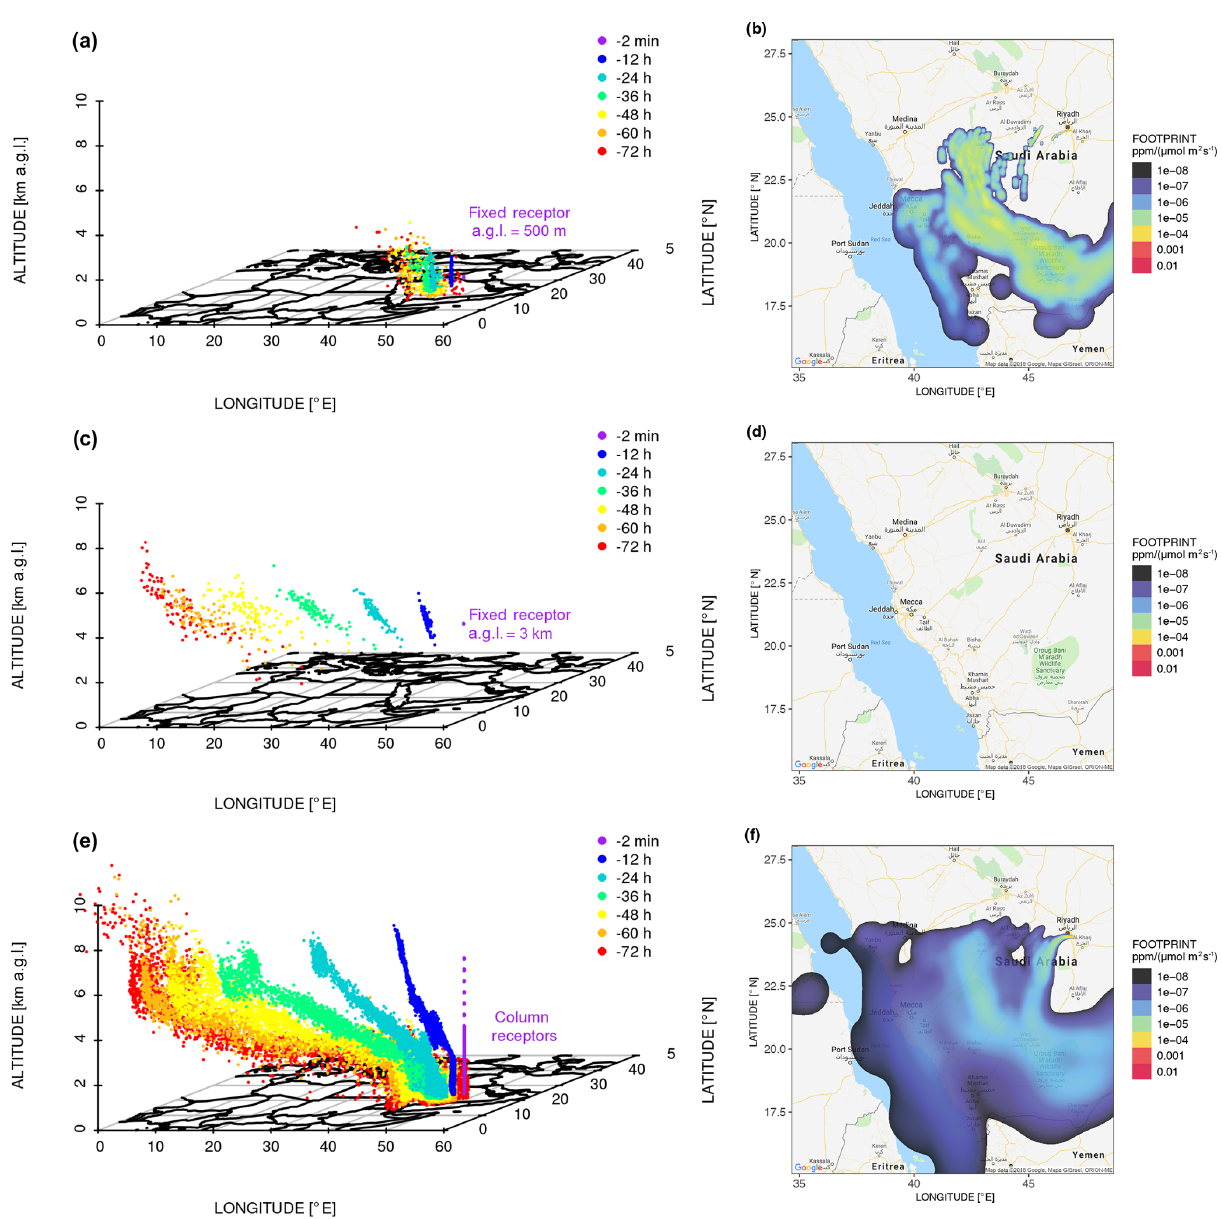
Figure 3. A 3-D scatterplot of STILT ensembles that are initially released from a fixed receptor of 500m (a) , 3km (c) , and column receptors (e) for Riyadh at 10:00UTC on 29 December 2014. The different colors represent the number of minutes/hours backwards ( − 2min, − 12, − 24, − 36, − 48, − 60, and − 72h) for each trajectory. Column receptors (e) are placed every 100m within 3km and every 500m from 3 to 6km. (b, d, f) Modeled fixed footprints versus column footprints are plotted using a blue to red gradient. Column footprints are weighted by pressure weighing functions. Only footprint values > 1E-8ppm / (µmolm − 2 s − 1 ) are